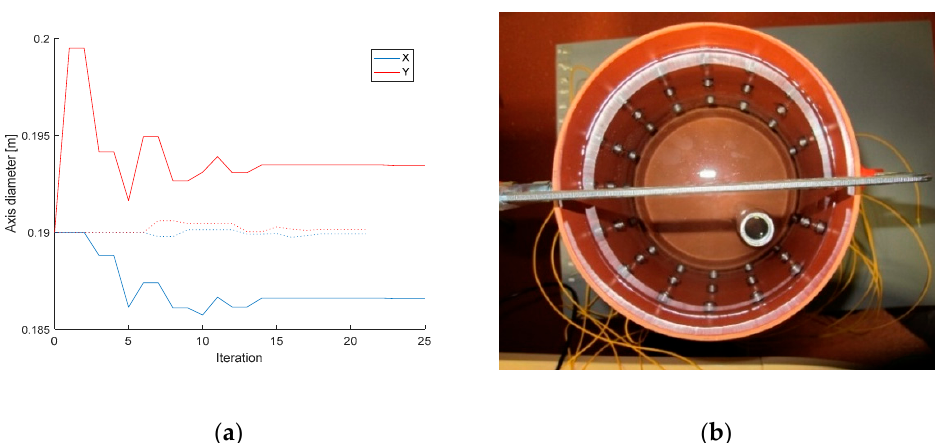
Figure 8. ( a ) The variation of the diameters on the axes X, Y, relating to the opposite stimulation pattern; solid lines and dotted lines show diameter convergence of accurate circular domain shape and non-optimized initial values of elliptical shape, respectively; ( b ) the tomograph filled with water and containing a circular aluminum object.